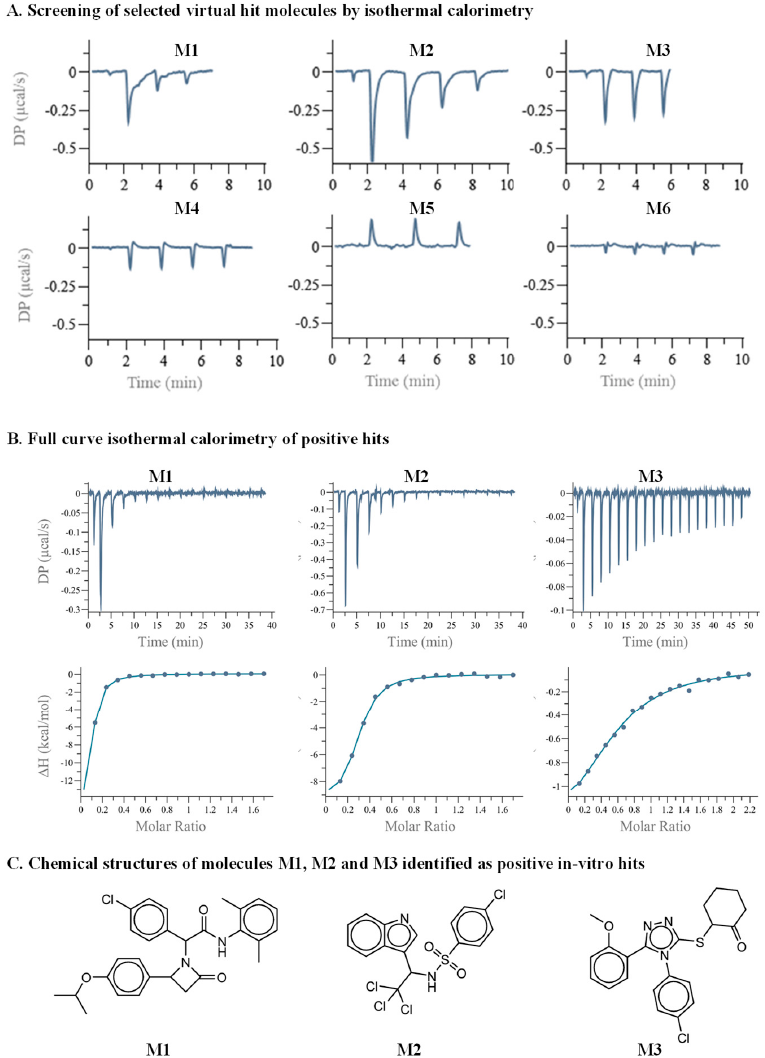
Figure 2. Secondary in vitro screening by ITC. ( A ) Three or four consecutive injections were executed, of MDM2 in the ITC syringe, at a concentration of 300 µ M, to the small molecules in the ITC cell, at a concentration of 30 µ M. The top row shows binding curves of molecules M1 to M3. The bottom row shows nonbinding curves of molecules M4 to M6. ( B ) Full ITC titration curves. ( C ) Chemical structures of molecules M1, M2, and